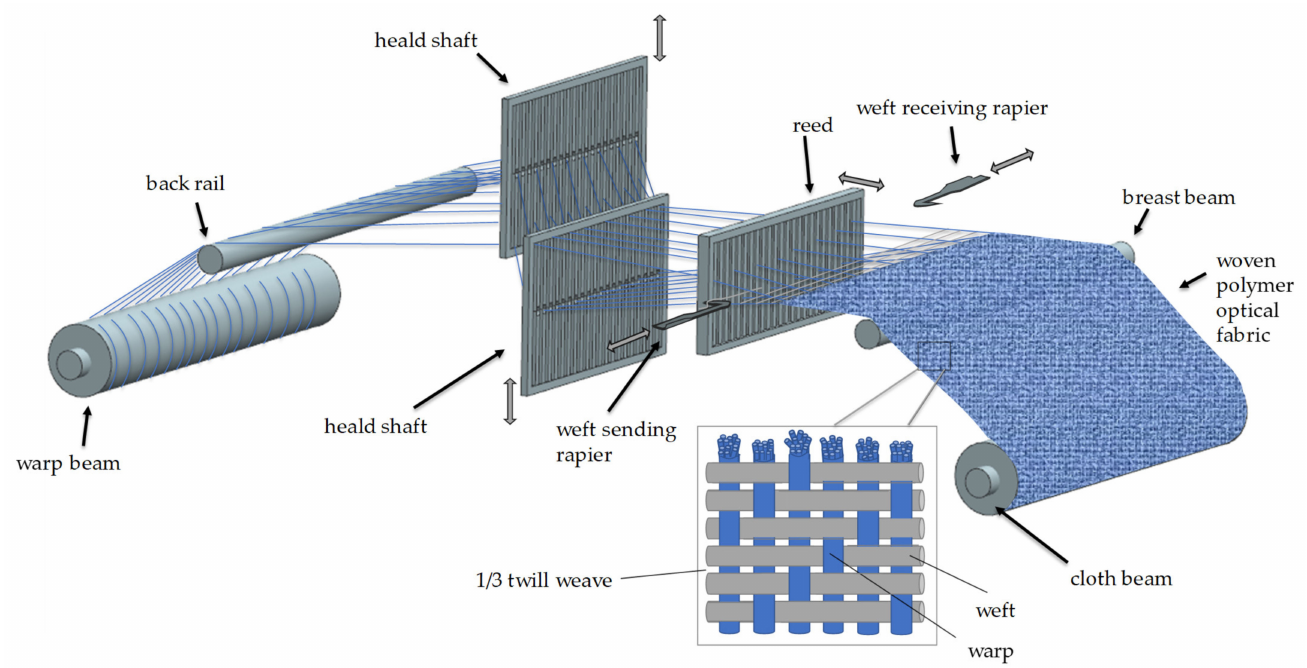
Figure 11. Weaving process with POF as weft